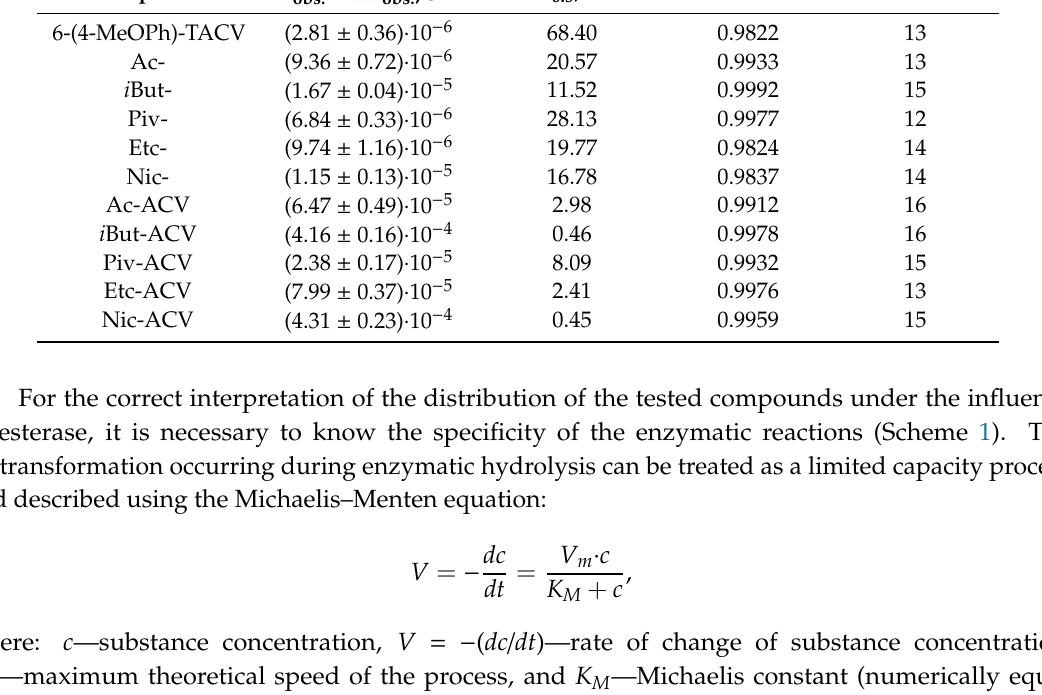
Table 2. The observed pseudo-first-order rate constants for the hydrolysis of test compounds in plasma (80%, 37 ◦ C).